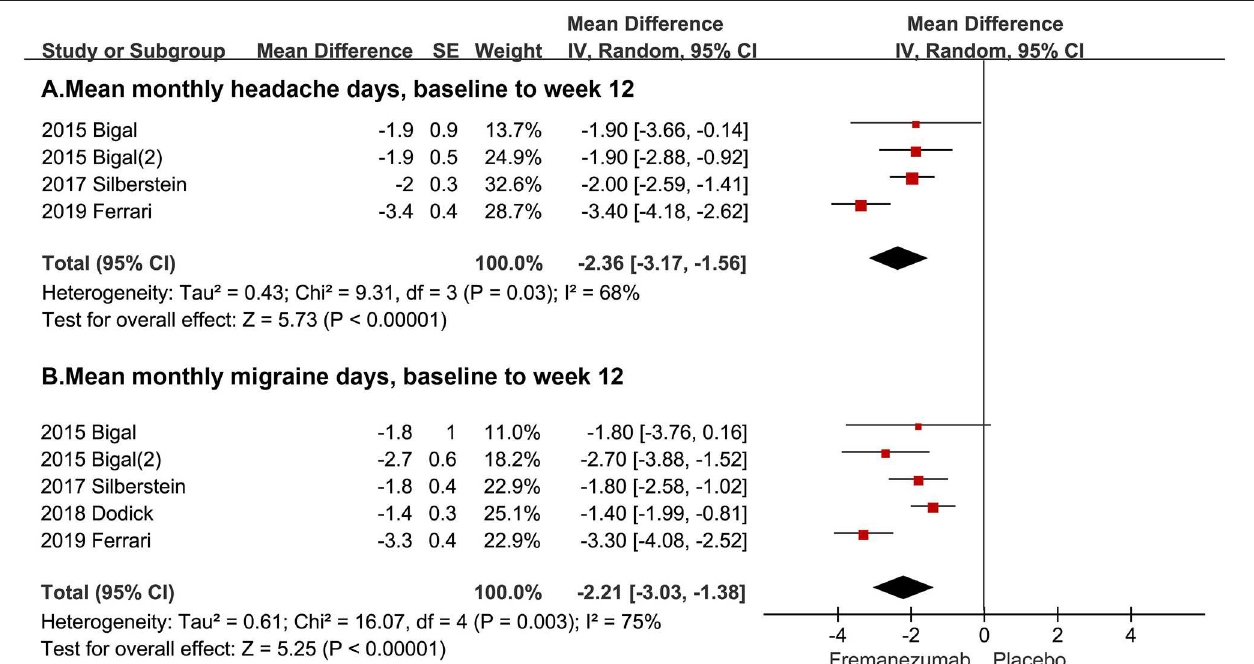
FIGURE 2 | The pooled MD of primary outcomes. The red square indicates the estimated MD for each RCT. The size of red square indicates the estimated weight of each RCT, and the extending lines indicate the estimated 95% CI of MD for each RCT. The black diamond indicates the estimated MD (95% CI) for all patients together. (A) Mean monthly headache days, baseline to week 12. (B) Mean monthly migraine days, baseline to week 12. Weights are from random-effects analysis. CI, confidence interval; RCT, randomized controlled trial; MD, mean